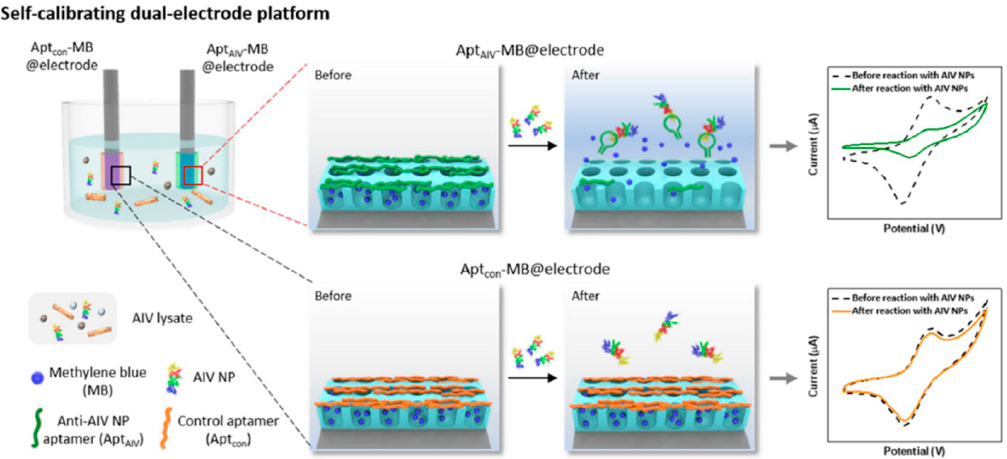
Figure 13. Self-calibrating dual electrochemical aptasensing platform using 3D porous silica nanostructure-modified rod electrodes for the determination of AIV. Reprinted from [92] with